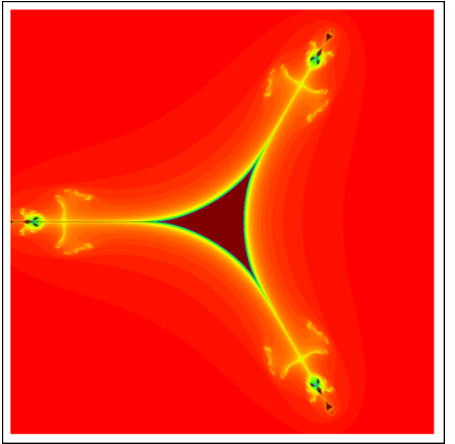
Figure 53. Tricorn via F-iteration with image visual time = 51.86 s.